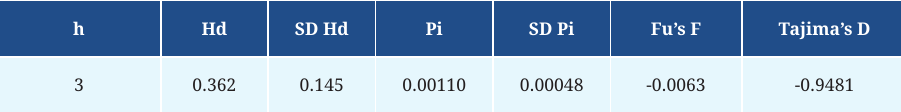
TABLE 6 | Diversity and neutrality indexes calculated for Acyrtus simon , Trindade Island. h = haplotypes standard deviation of π.